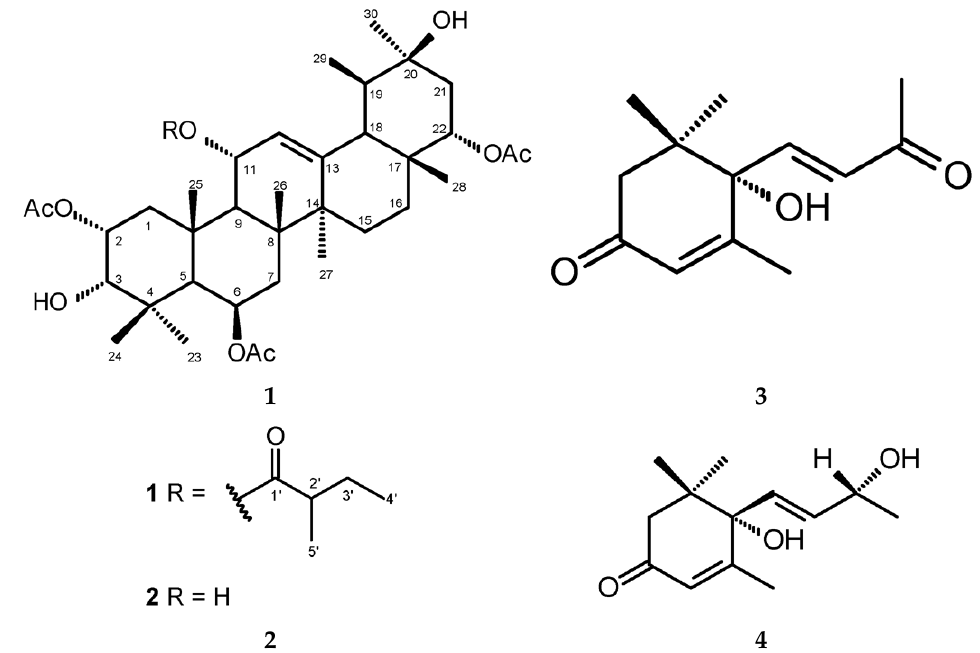
Figure 1. Chemical structures of 2 α ,6 β ,22 α -triacetoxy-11 α -(2 (cid:48) -methylbutyryloxy)-urs-12-ene-3 α ,20 β -diol ( 1 ), 2 α ,6 β ,22 α - triacetoxy-urs-12-ene-3 α ,11 α ,20 β -triol ( 2 ), (+)-dehydrovomifoliol ( 3 ) and (+)-vomifoliol ( 4